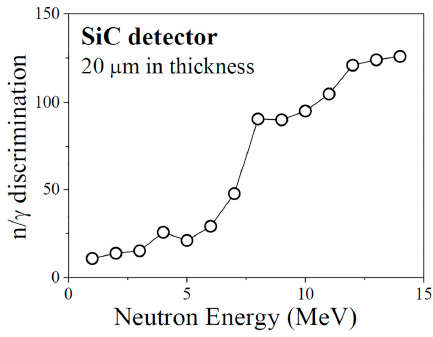
Figure 8. n/ γ discrimination of an SiC detector with a thickness of 20 μ m, for the neutrons of 14 MeV and the γ -rays of 1.25 MeV.